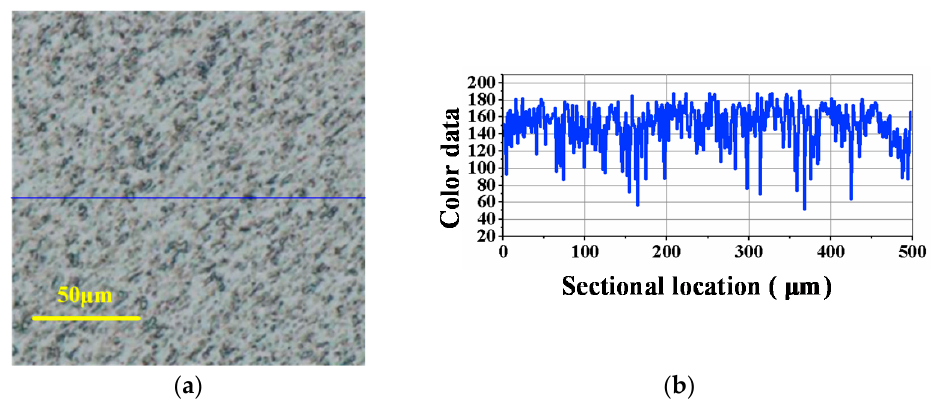
Figure 10. Optical image and sectional surface profile after ultrasonic-assisted lapping using copper disc (6.11 μ m/min): ( a ) Surface defects; ( b ) Color data of the sectional profile.